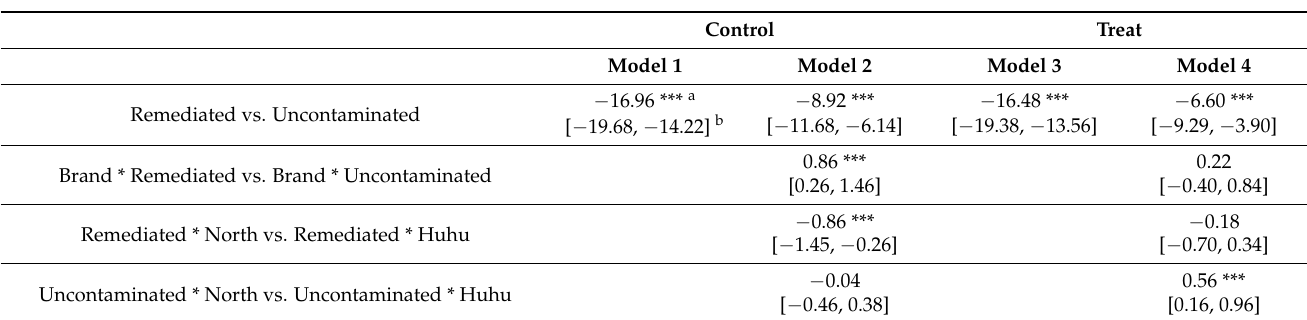
Table 5. Wald test